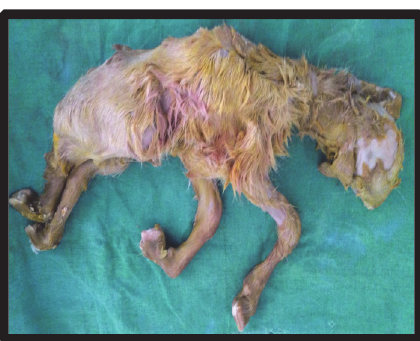
Figure 1: Dead twins at 60 days of gestation (arrows).